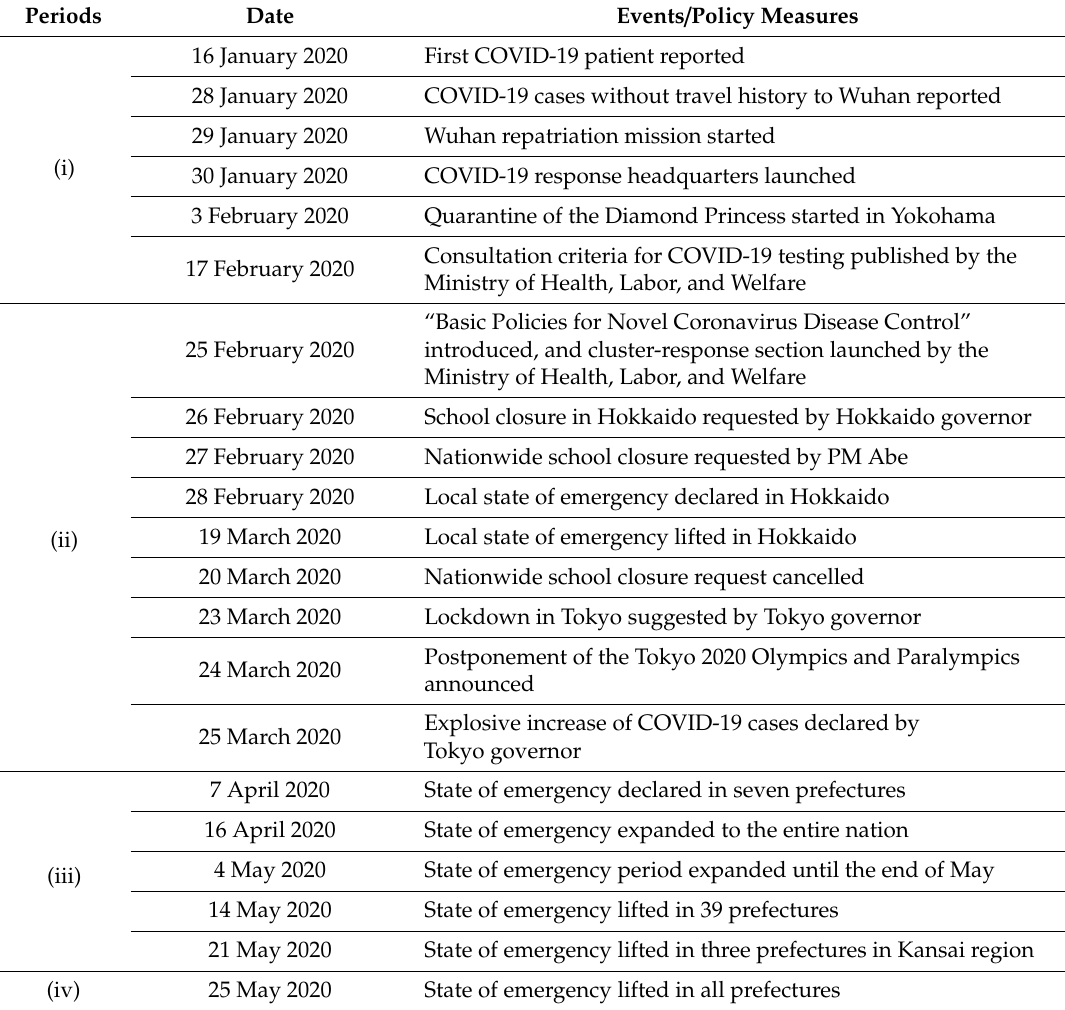
Table 1. Key policy measures in Japan’s response to COVID-19, January–May, 2020.